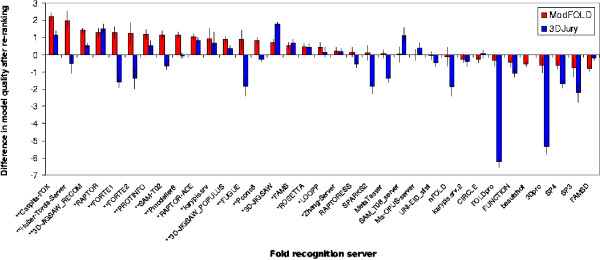
The added value of re-ranking models. The difference in the cumulative observed model quality score of the top ranked models is shown after the 5 models for each target provided by each server are re-ranked using the ModFOLD or 3D-Jury methods. Each bar represents Σ(mi-mj), where mi is the observed model quality of the top ranked model after the 5 server models are re-ranked and mj is the observed model quality of the original top ranked model submitted by the server. N.B. Only the common subset of servers which had submitted 5 models for all targets are included in the plot. The error bars show the standard error of the mean observed quality. Overall there is a mean increase of 0.44 in the cumulative observed model quality of the top ranked models if the ModFOLD method is used to re-rank the models provided by individual servers, however, there is a mean decrease of 0.56 if models are re-ranked using the 3D-Jury method (see Table 9). On the x axis, the first asterisk indicates a fold recognition server where the quality of the top ranking model can be significantly improved. An additional asterisk indicates a significant improvement of the ModFOLD method over the 3D-Jury method.